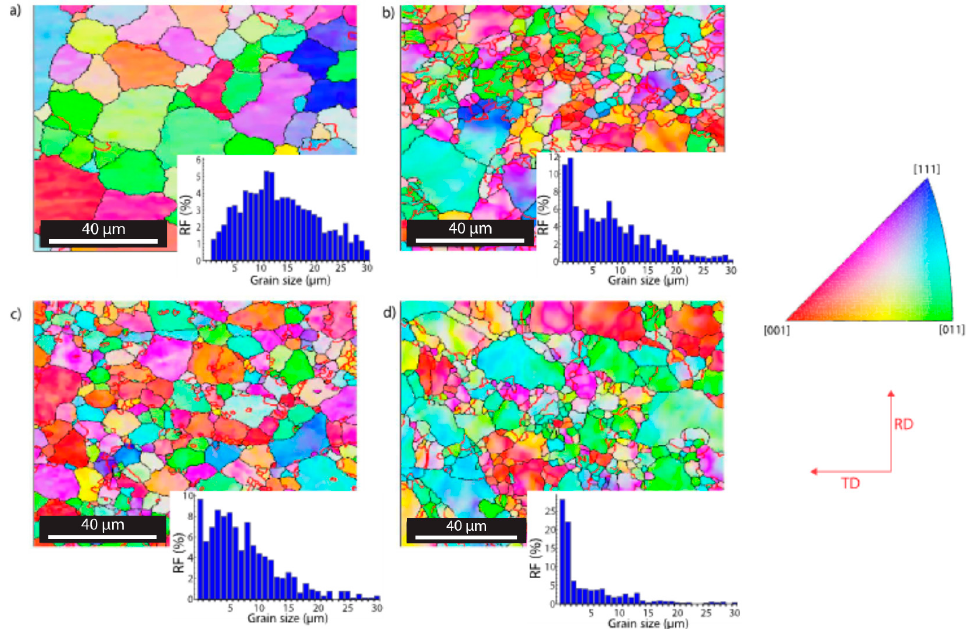
Figure 9. Electron backscatter diffraction (EBSD) orientation maps with grain size histogram (RF% means relative frequency) for ( a ) initial condition, ( b ) one RCS cycle, ( c ) two RCS cycles, ( d ) four RCS cycles. These results showed the RCS effect on the grain size distribution. Metals 2020 , 10 , x FOR PEER REVIEW